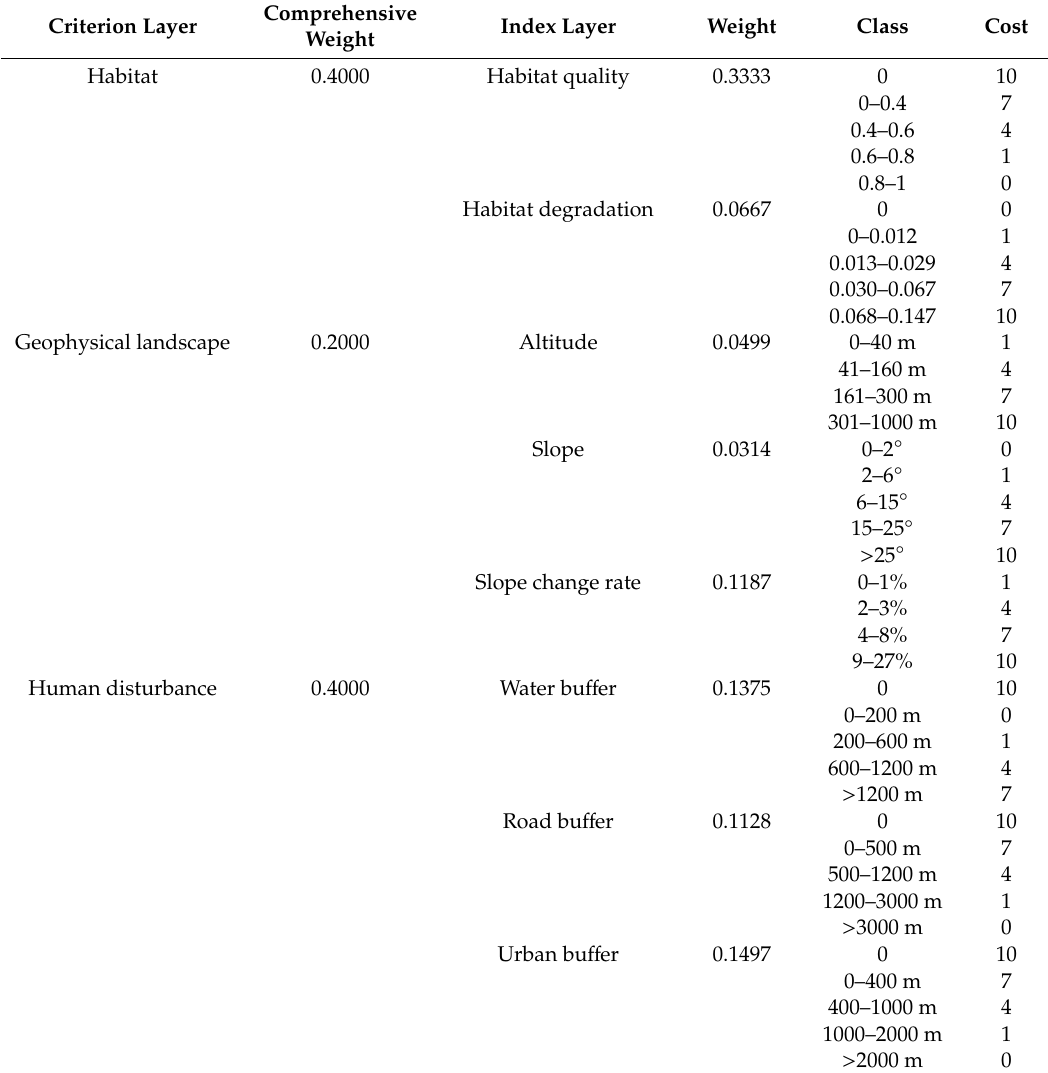
Table 4. Evaluation indicators for small mammal cost